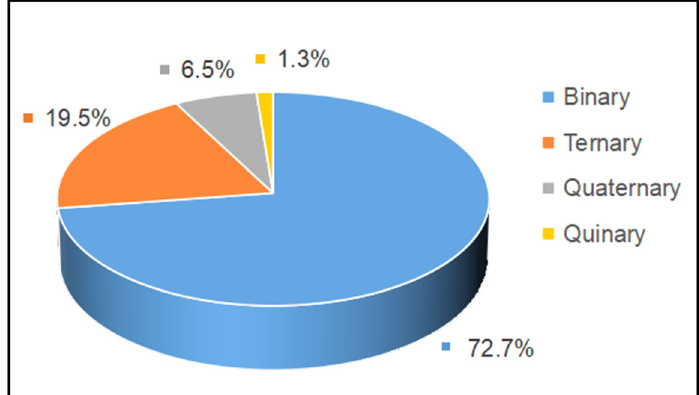
Figure 3. The proportion of studies investigating edible oil blends with different number of com- ponent oils in literature from 2002–2022.